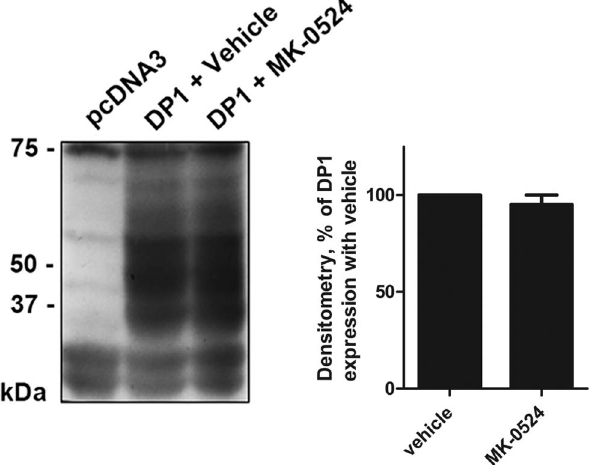
Figure 5. The total expression of the DP1 protein is not modulated by MK-0524. Lysates of HEK293 cells transiently expressing Flag-DP1 incubated for 24 h with vehicle or 1 m M of MK- 0524 were analyzed by Western blot using a monoclonal Flag antibody. The blot shown is representative of three separate experiments. IB ,